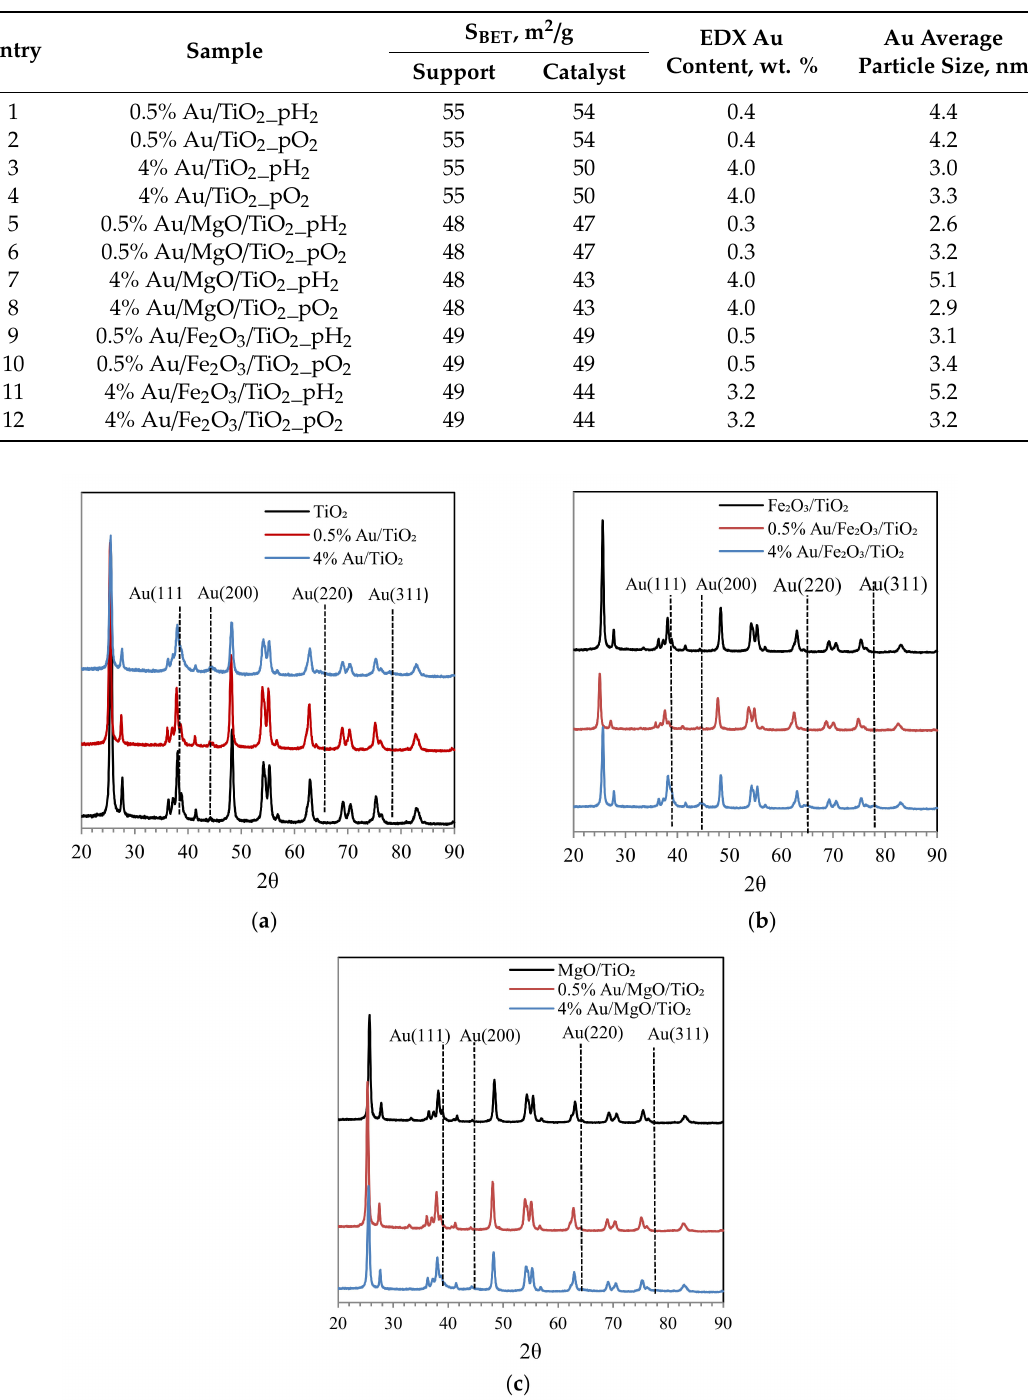
Table 2. Textural properties of supports and catalysts, analytical content and particle size of Au. Data for Entries 1–4 taken from [31,32].